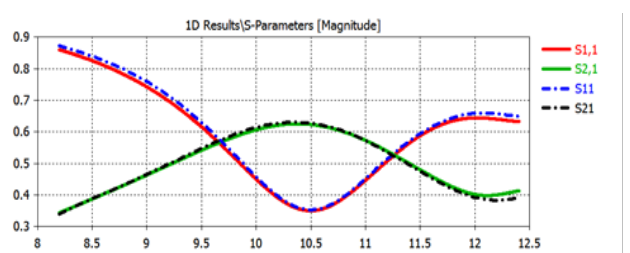
Fig. 3. The module of the reflection and transmission coefficients of the АН - МКХ2 material samples: solid curves – calculated, dash-dotted curves – measured.